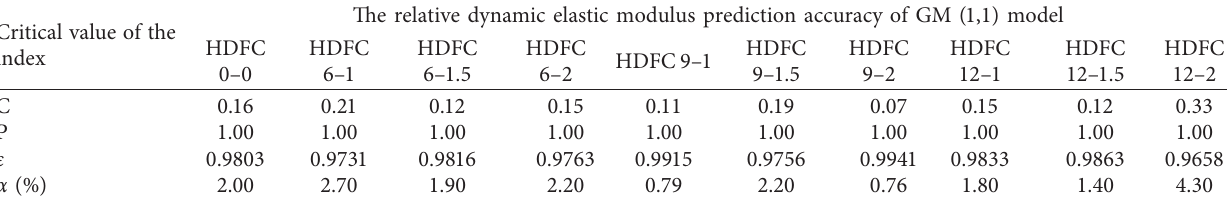
Table 9: GM (1,1) model accuracy prediction